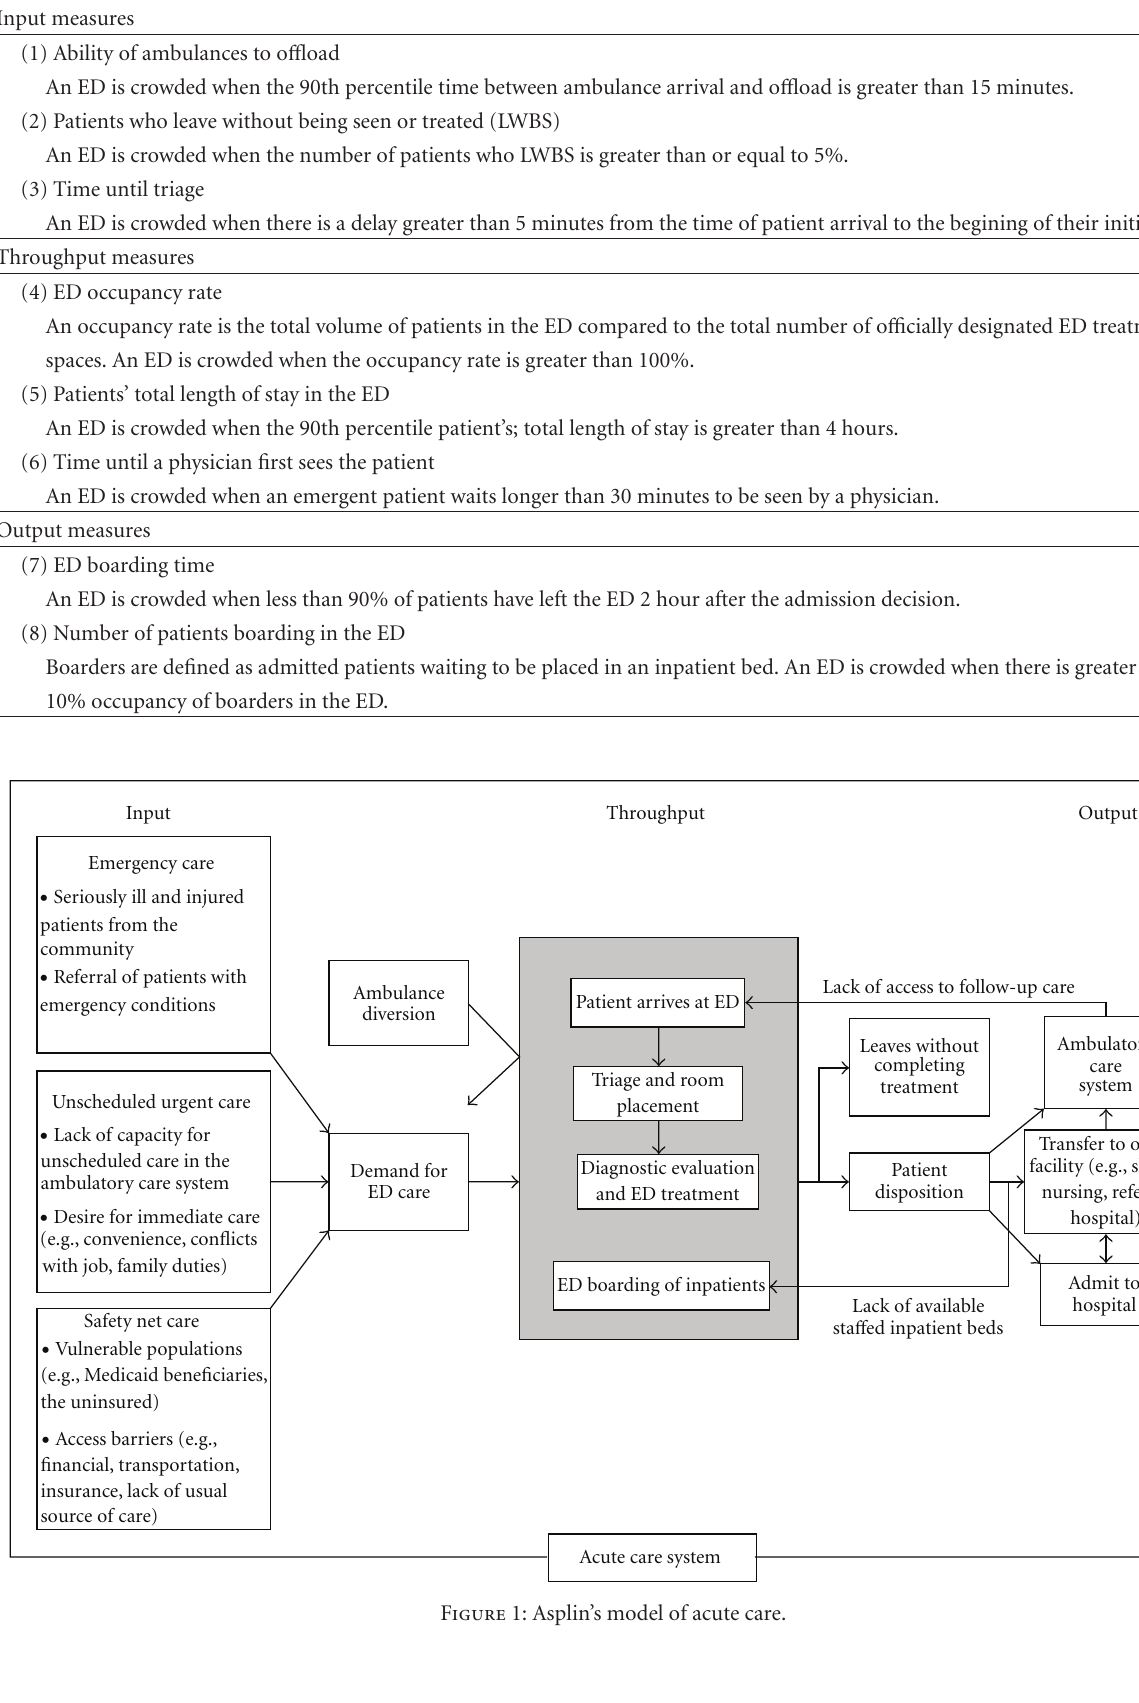
Table 2: A consensus definition of emergency department crowding [42].